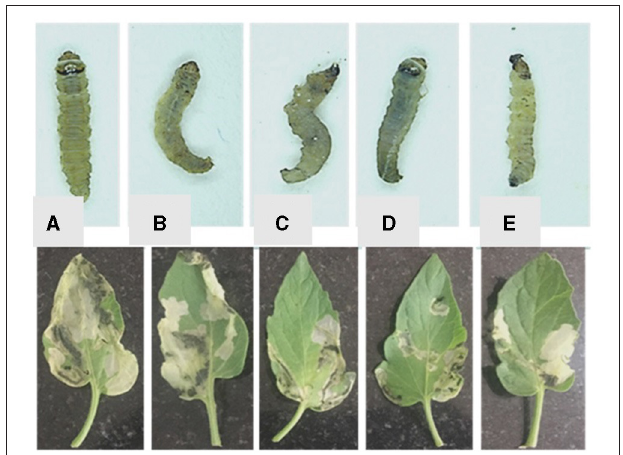
FIGURE 3 | Single leaf feeding assay. There was an observed correlation between decreased feeding damage to leaves with increasing dsRNA concentrations (A) 10 µ g dsRNA /cm 2 , up to (E) 50 µ g dsRNA /cm 2 . Individual leaves were coated with dsRNA solution at different concentrations